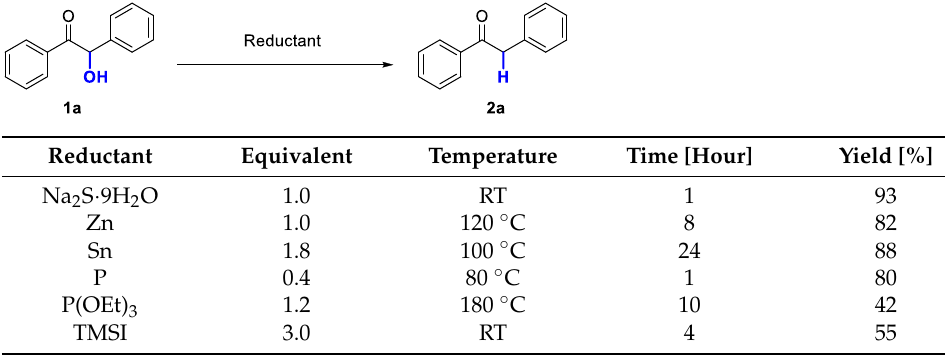
Table 2. Comparison of different reductants for the dehydroxylation of benzoin.